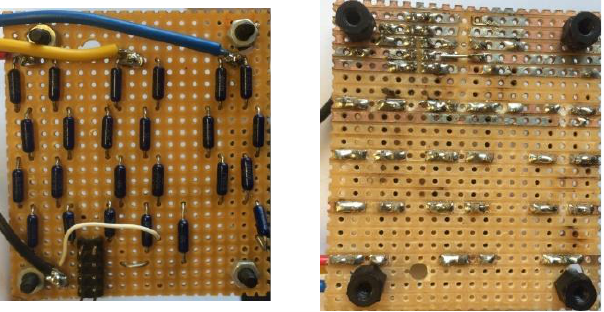
Figure 8. Front ( left ) and back view ( right ) of completed resistor board.